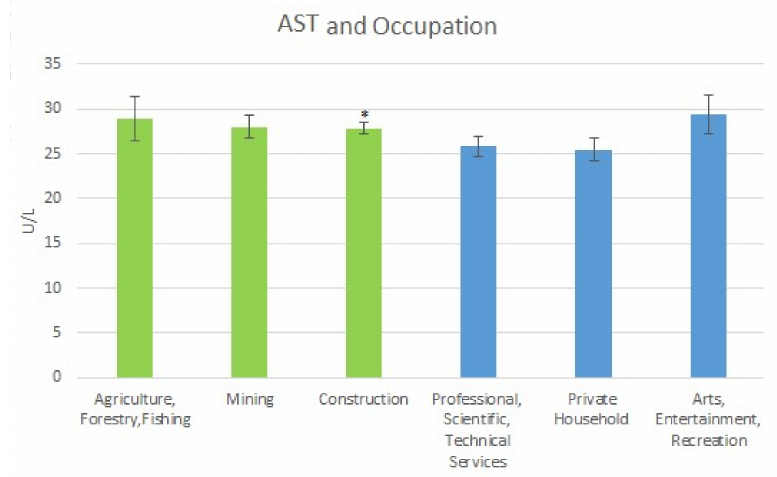
Figure 2. Occupation and Mean AST Levels. * Moderately Significant difference between Construction and Private